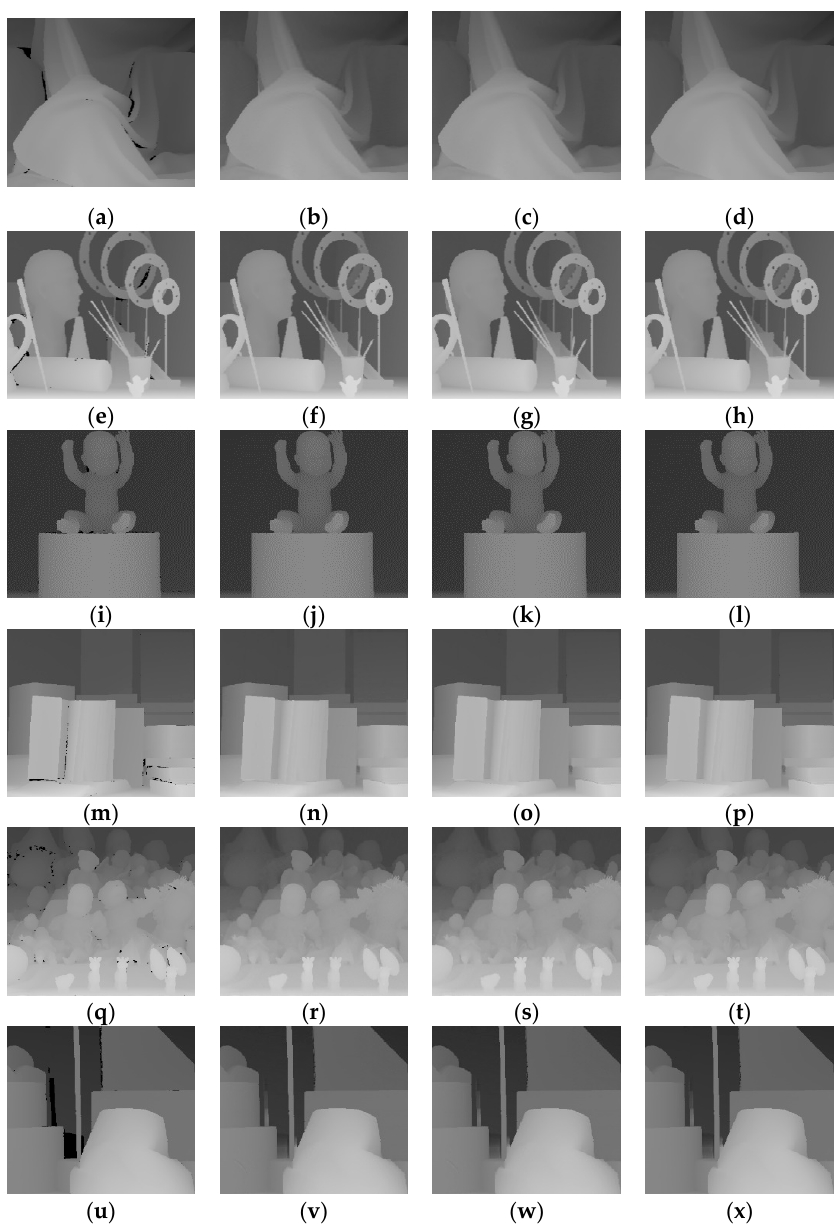
Figure 4. Visual quality comparison of the inpainting result (1): ( a ) Aloe depth image; ( b – d ) inpainting effects of the nuclear norm minimisation (NNM) algorithm, weighted Schatten p- norm